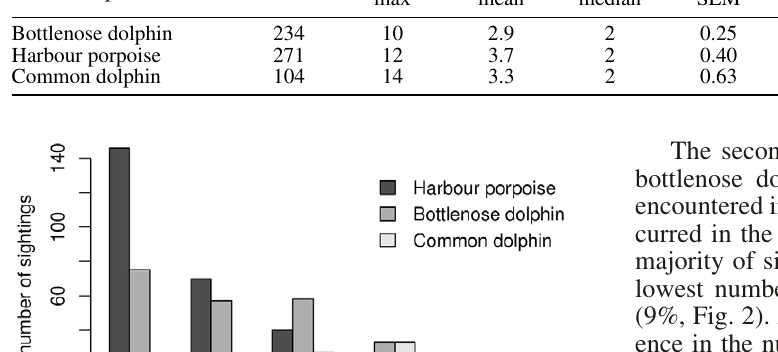
Table 2. – Descriptive statistics of animal sightings and group size for three species of Black sea cetaceans. n, sample size; max, maximum number of sightings in one observation day/specimens in one group; SEM, standard error of the mean. Species